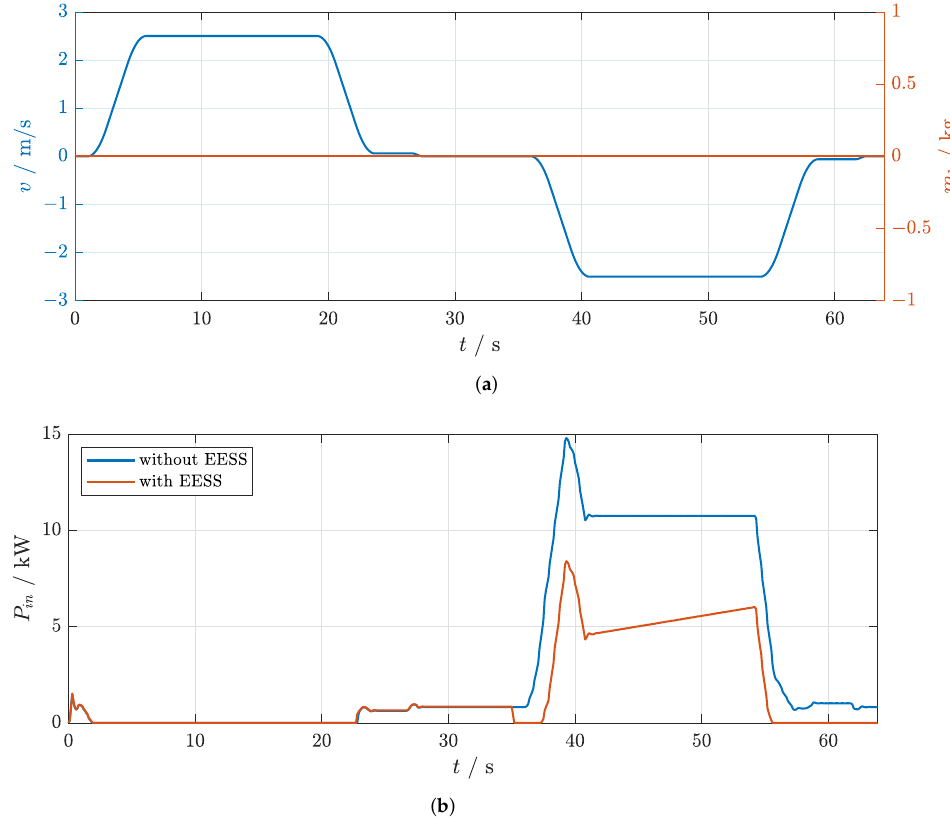
Figure 11. Simulation results for the reference cycle. ( a ) Elevator speed setpoint and mass of the load. ( b ) Input